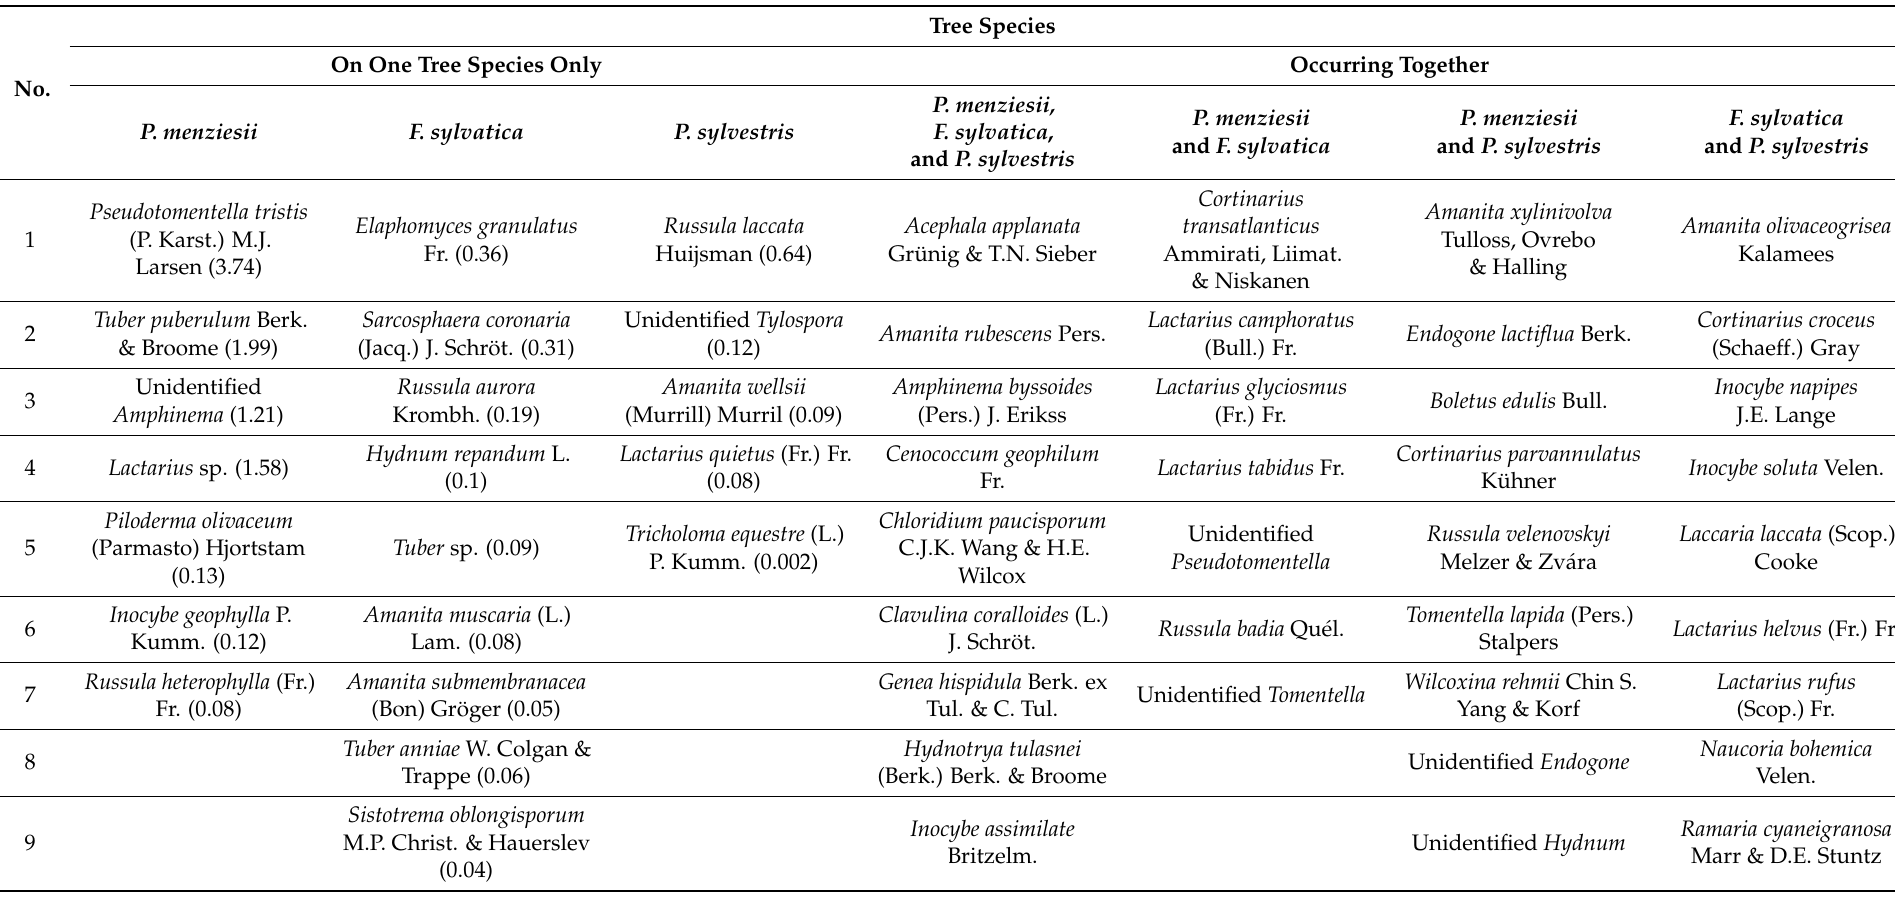
Table 4. Identified EM and AM taxa inhabiting Pseudotsuga menziesii , Fagus sylvatica , and Pinus sylvestris fine roots. In brackets: relative abundance >0.003% and soil parameters significantly correlated ( p <